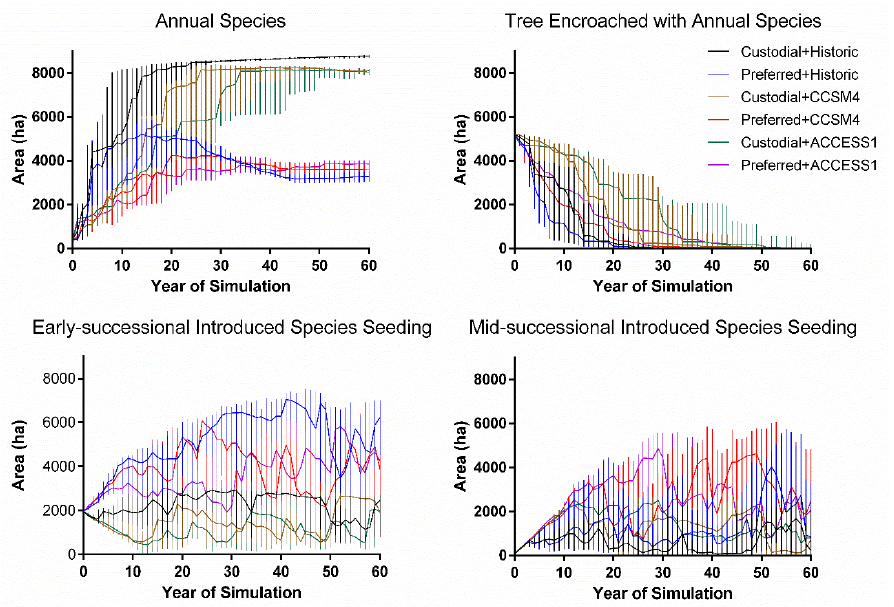
Figure 7. Median area (ha) of dominant treated and recipient classes of montane sagebrush steppe in the Black Mountains. Error bars are 25% and 75% quartile range based on 10 Monte Carlo replicates.